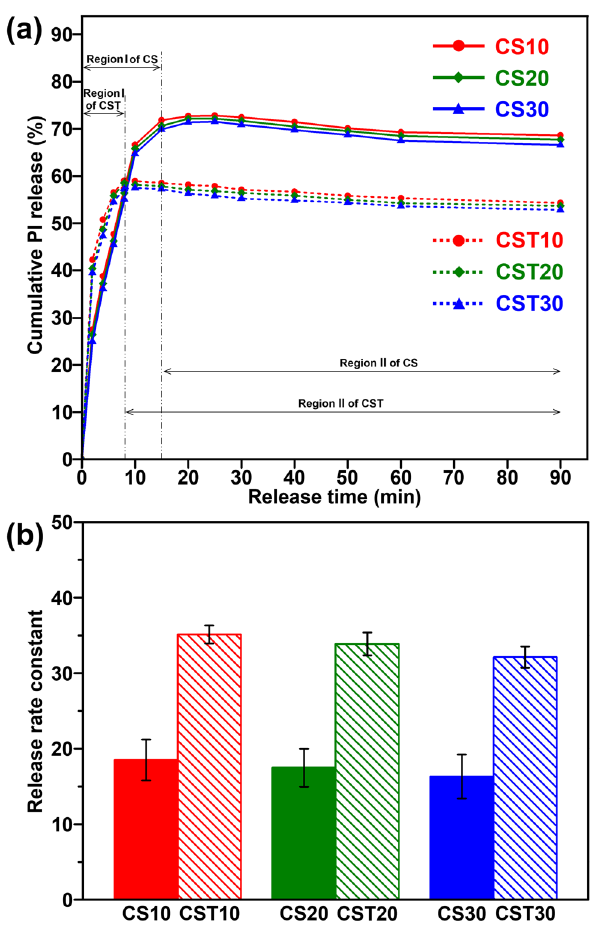
Figure 9: ( a ) Cumulative PI release pro fi le and ( b ) release rate of the nano fi ber mats with and without T80 addition.